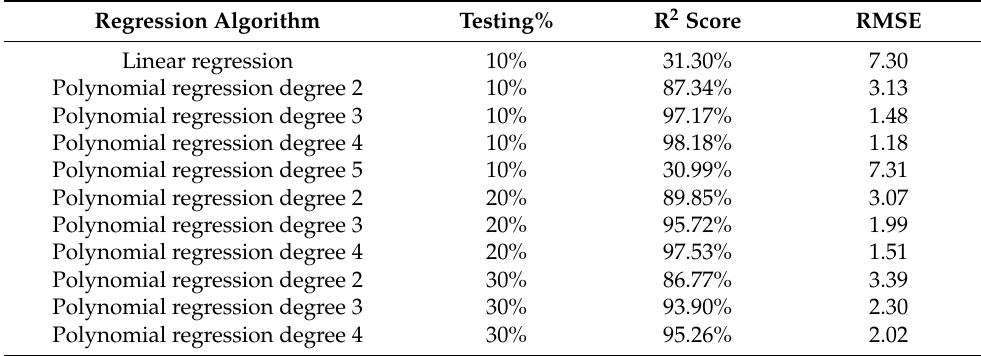
Figure 13. Predicted versus actual M DCO of dc-biased pulse amplitude modulated orthogonal frequency division multiplexing (DPO-OFDM) for the case of polynomial regression of degree = 4. Note that M DCO stands for the constellation size of DC-biased optical OFDM (DCO-OFDM). Table 1. Performance of different regression algorithms.